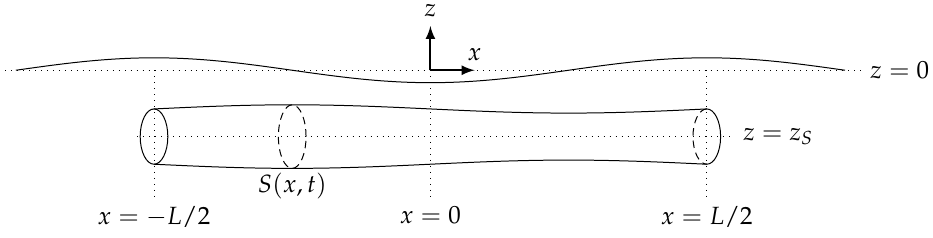
Figure 1. Schematic of a bulging S3 wave energy converter, as studied in the